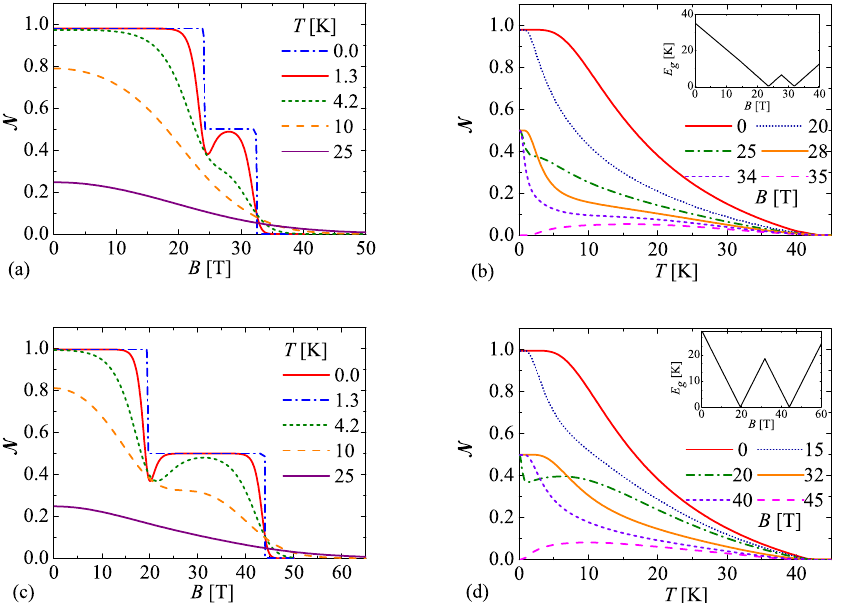
Figure 7. ( a , b ) The negativity of the NAOC complex when the external magnetic field is applied along the crystallographic c ∗ -axis. Magnetic-field [panel ( a )] and temperature [panel ( b )] dependencies of the negativity are based on the spin-1 Heisenberg dimer (1) with the isotropic coupling constant J / k B = 30.66 K and ∆ = 1, the uniaxial single-ion anisotropy D c ∗ / k B = − 12.48 K and the gyromagnetic factor g c ∗ = 2.28; ( c , d ) The negativity of the NAOC complex when the external magnetic field is applied along the crystallographic a -axis. Magnetic-field [panel ( c )] and temperature [panel ( d )] dependencies of the negativity are based on the spin-1 Heisenberg dimer (1) with the isotropic coupling constant J / k B = 30.66 K and ∆ = 1, the uniaxial single-ion anisotropy D a / k B = 4.91 K and the gyromagnetic factor g a =